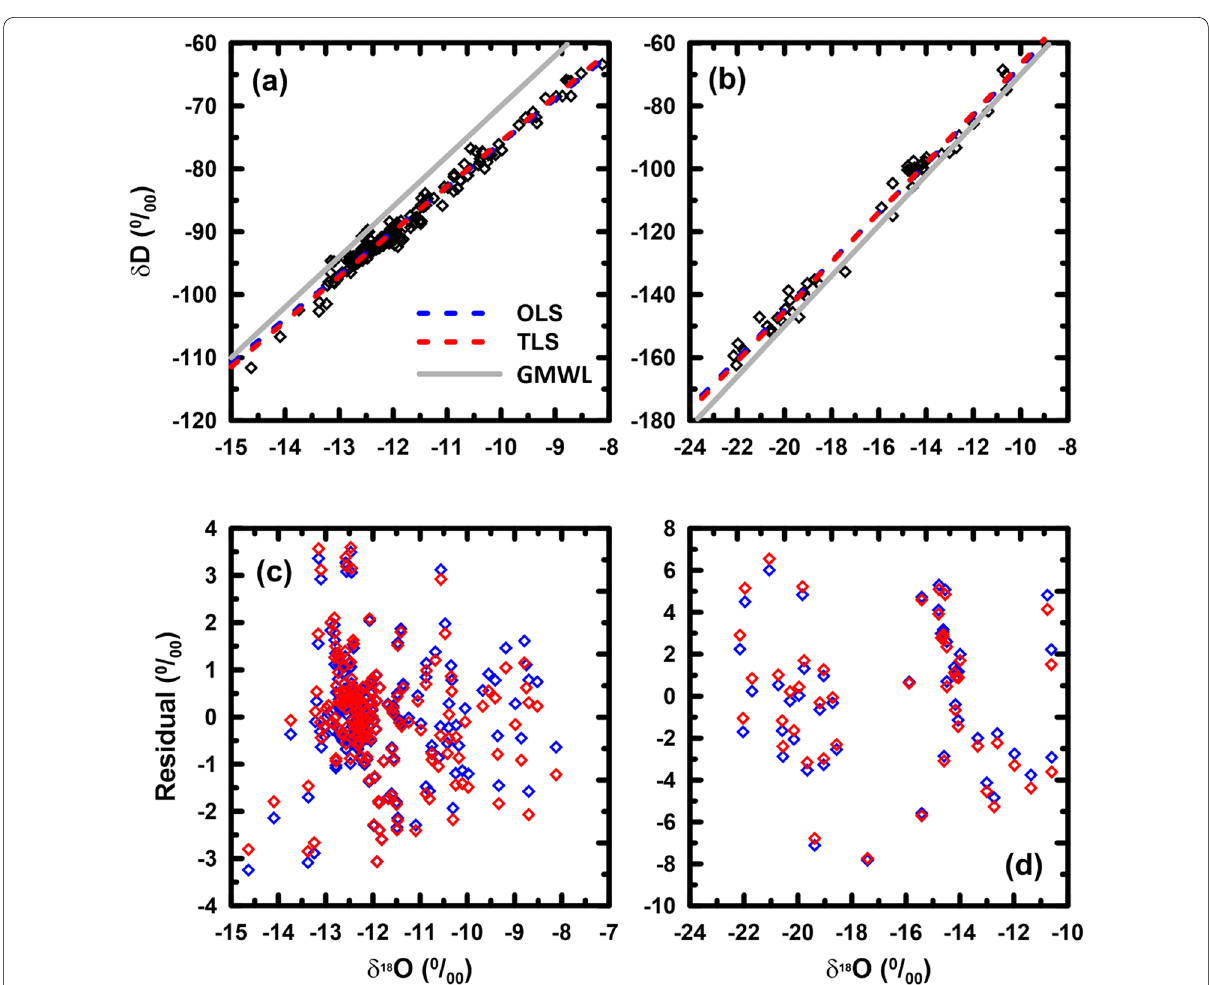
Fig. 2 a The linear relationship between oxygen and hydrogen isotopes of snow and snowmelt sampled from the King Sejong Station obtained using OLS and TLS. b The linear relationship between oxygen and hydrogen isotopes of water vapor obtained using OLS and TLS (Lee et al. 2013). c A comparison of the residuals of oxygen isotopes obtained using OLS and TLS d A comparison of the residuals oxygen isotopes obtained using OLS and